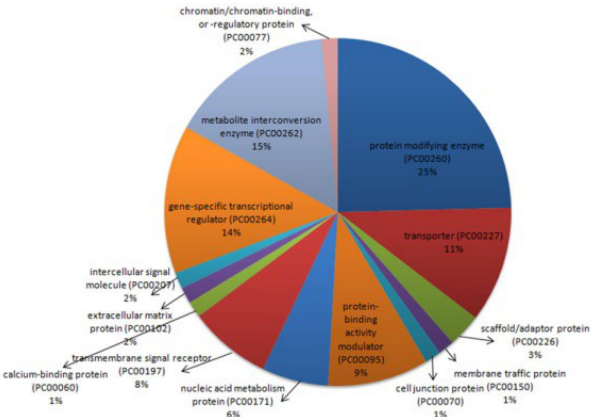
Figure 1. MCODE clustering of miR-122 interactors. ( A ) Largest cluster with twenty-three genes; ( B ) Second largest cluster with nine genes.